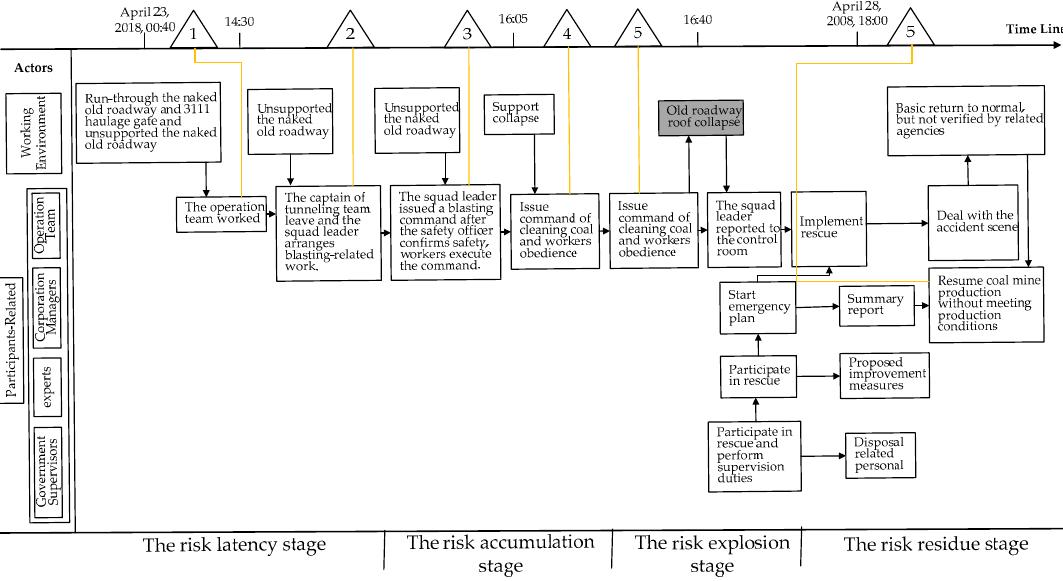
Figure 2. The development of the “4-24” major roof accident.